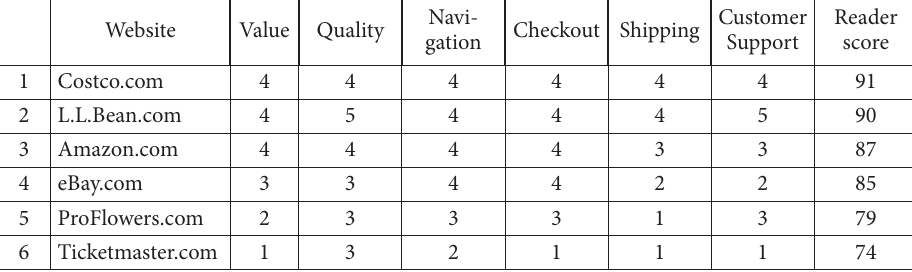
Table 14. Survey scores on a 1–100 scale Website Value Qua lity